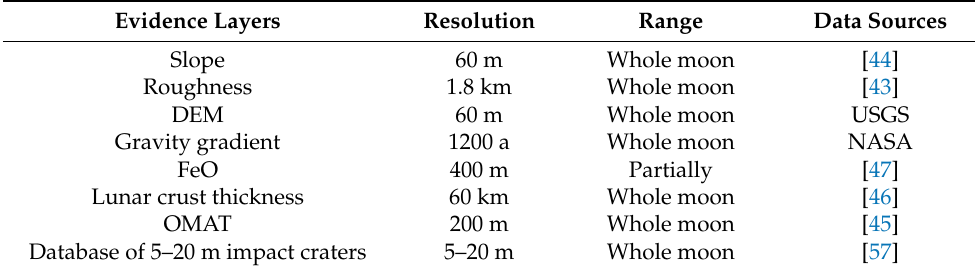
Table 1. Display of relevant parameters of the dataset used.